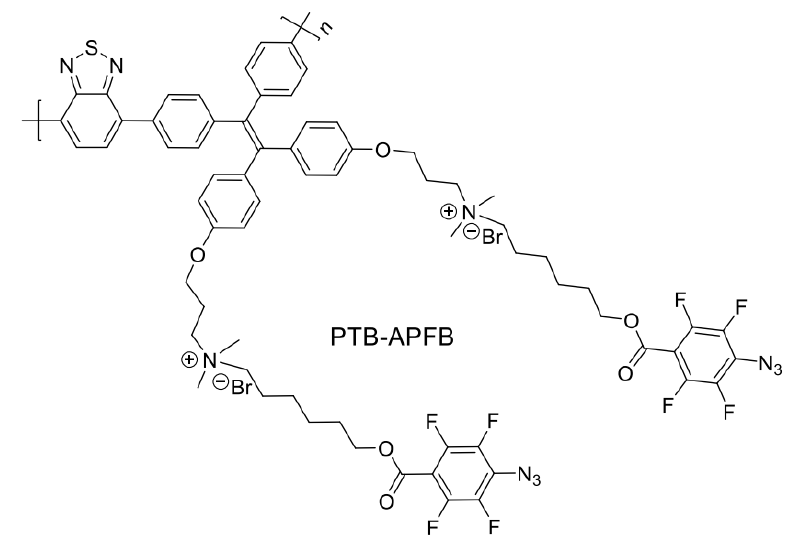
Figure 22. Structure of the PTB-APFB polymer. Adapted with permission from reference [157]. Copyright 2020, John Wiley and Sons.